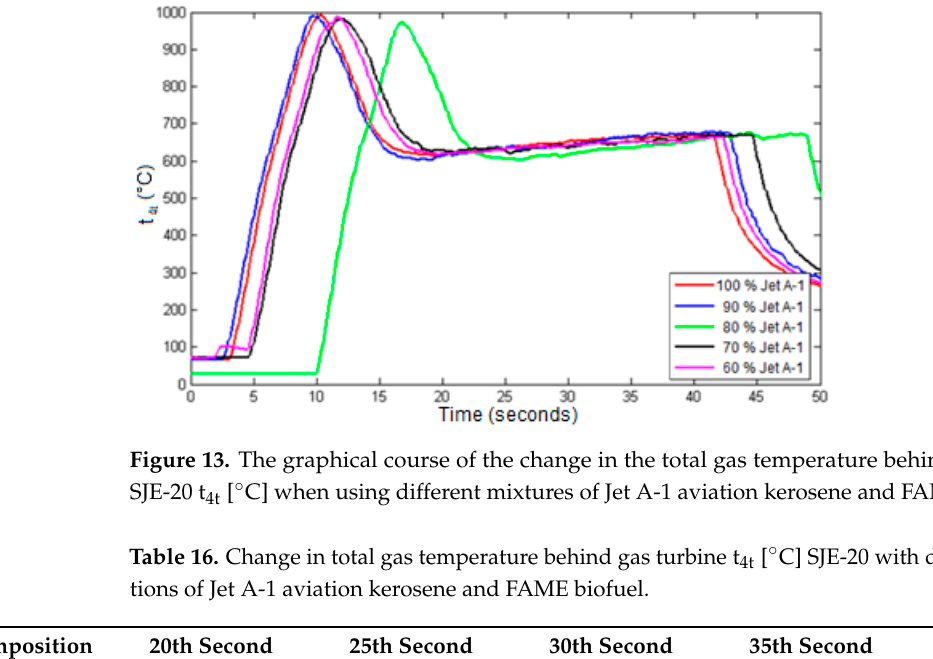
Table 16. Change in total gas temperature behind gas turbine t 4t [°C] SJE-20 with different concentrations of Jet A-1 aviation kerosene and FAME biofuel.